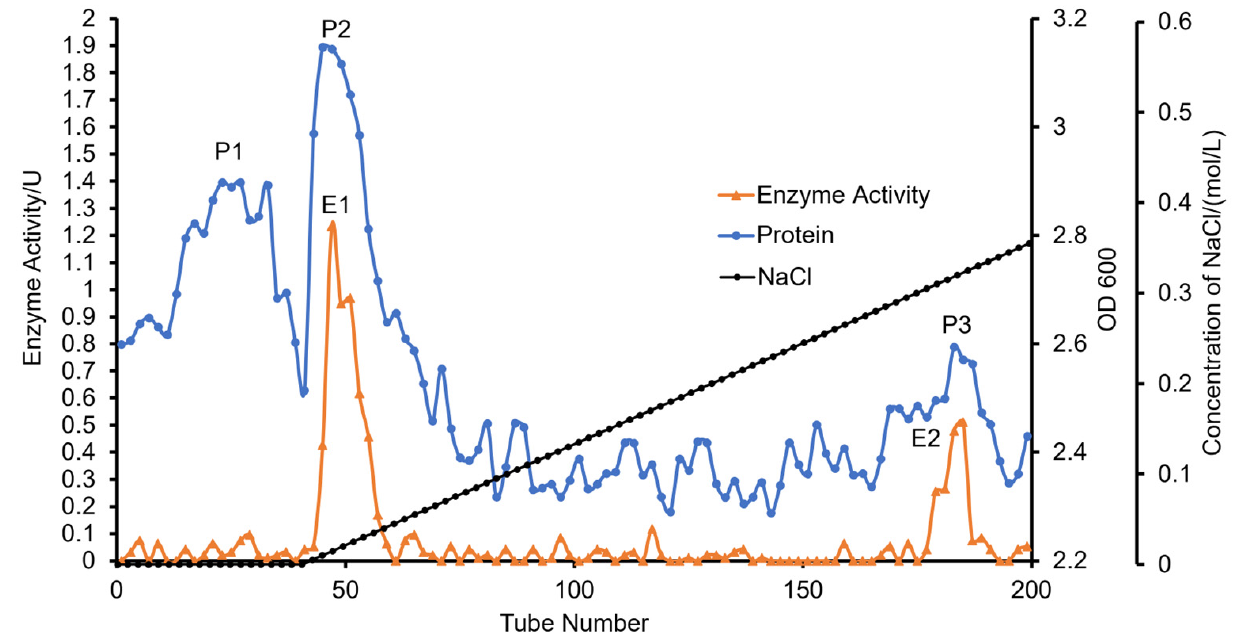
Figure 4. Elution curve of fucoidanase via DEAE Sepharose fast flow column chromatography. P1, P2 and P3 are three peaks of protein, and E1, E2 are two peaks of enzymatic activity.